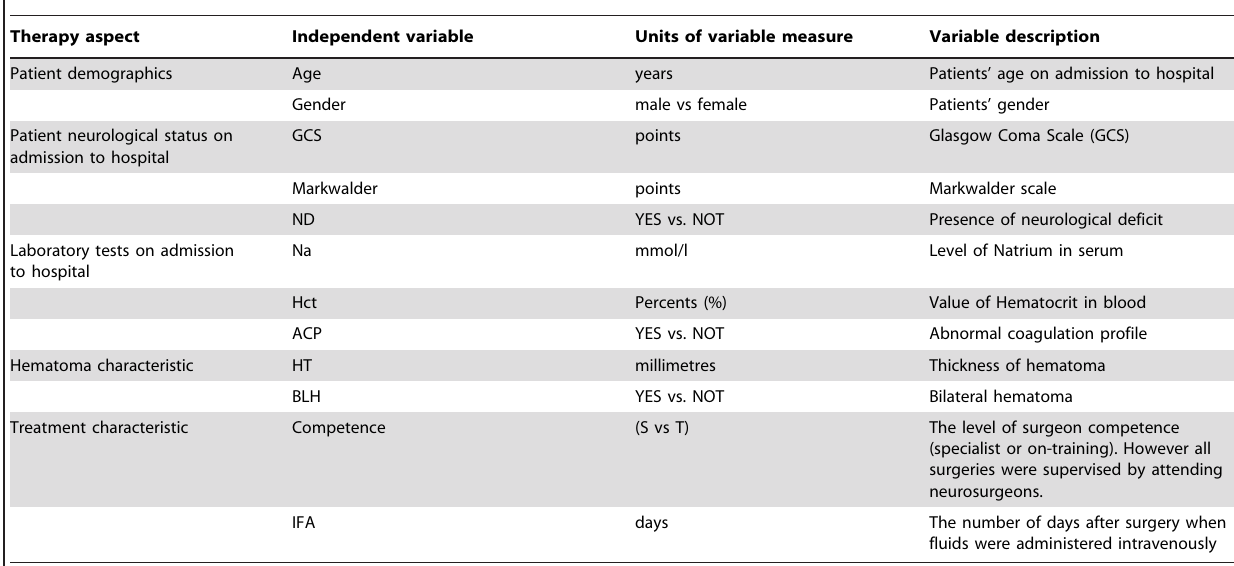
Table 1. Description of independent variables selected for regression analysis.